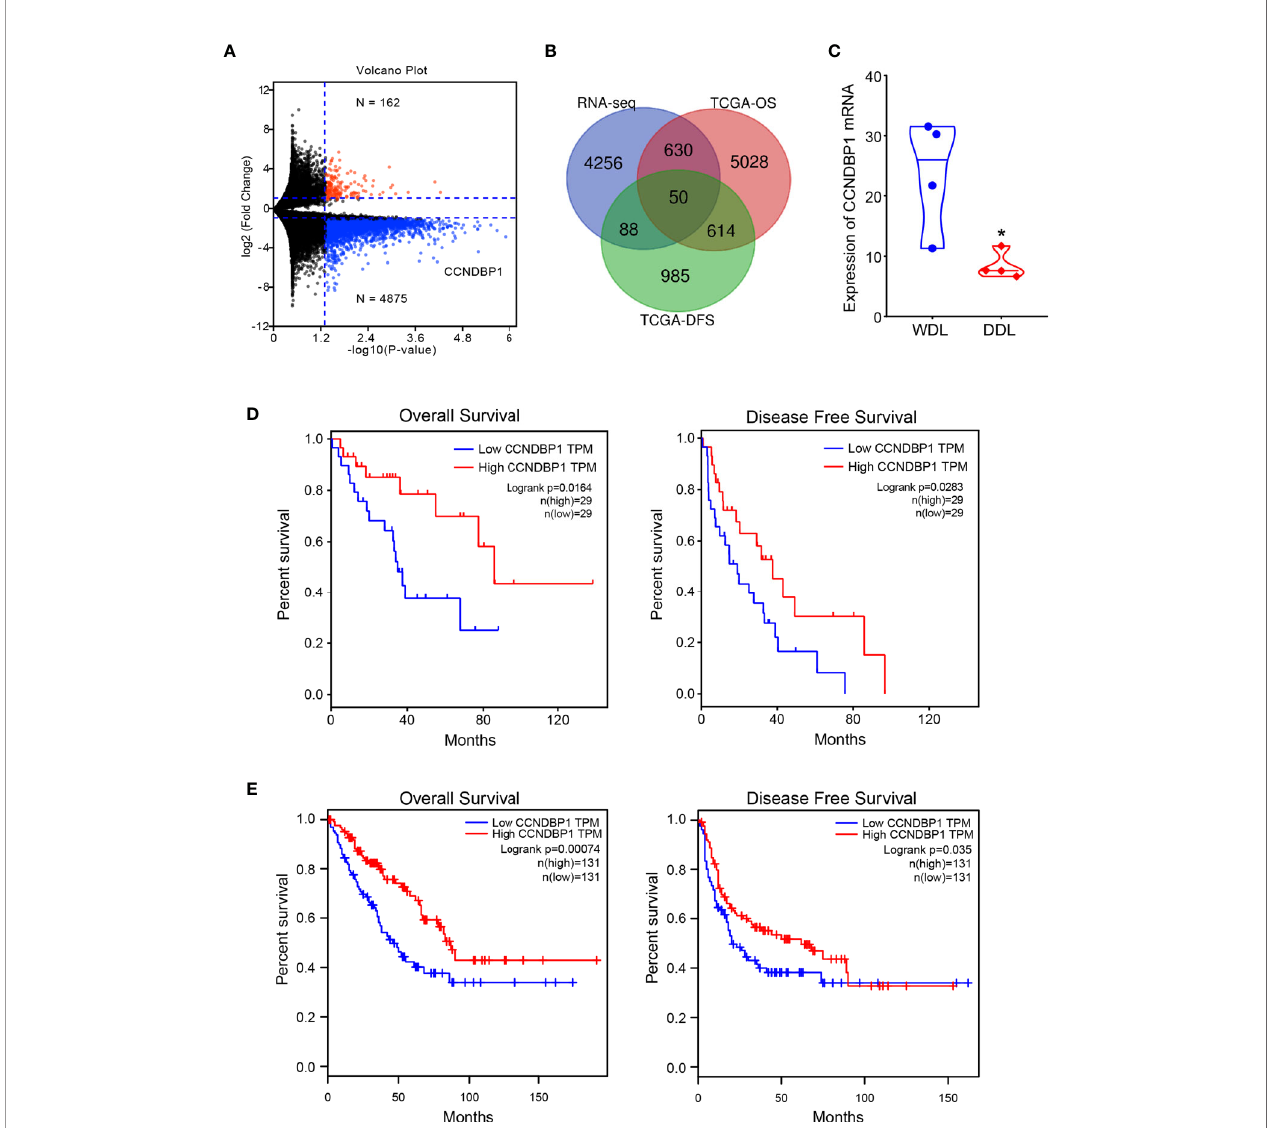
FIGURE 1 | CCNDBP1 was a differential gene with a prognostic value between WDL and DDL. (A) Differential genes detected by high-throughput sequencing, red indicates upregulated genes and blue indicates downregulated genes in DDL compared with WDL; (B) Venn diagram, 50 genes that have expression differences between tissues of WDL and DDL, and have predictive value for the prognosis of patients; (C) the mRNA expression of CCNDBP1 had a signi fi cant difference between WDL and DDL tissues; (D) The expression level of CCNDBP1 in 58 patients with DDL in the TCGA database was correlated with the prognosis of the patients and the higher the expression level of CCNDBP1, the better the prognosis of patients; (E) The GEPIA database veri fi ed that the low expression of CCNDBP1 was a poor prognostic factor in patients with sarcoma. *P <